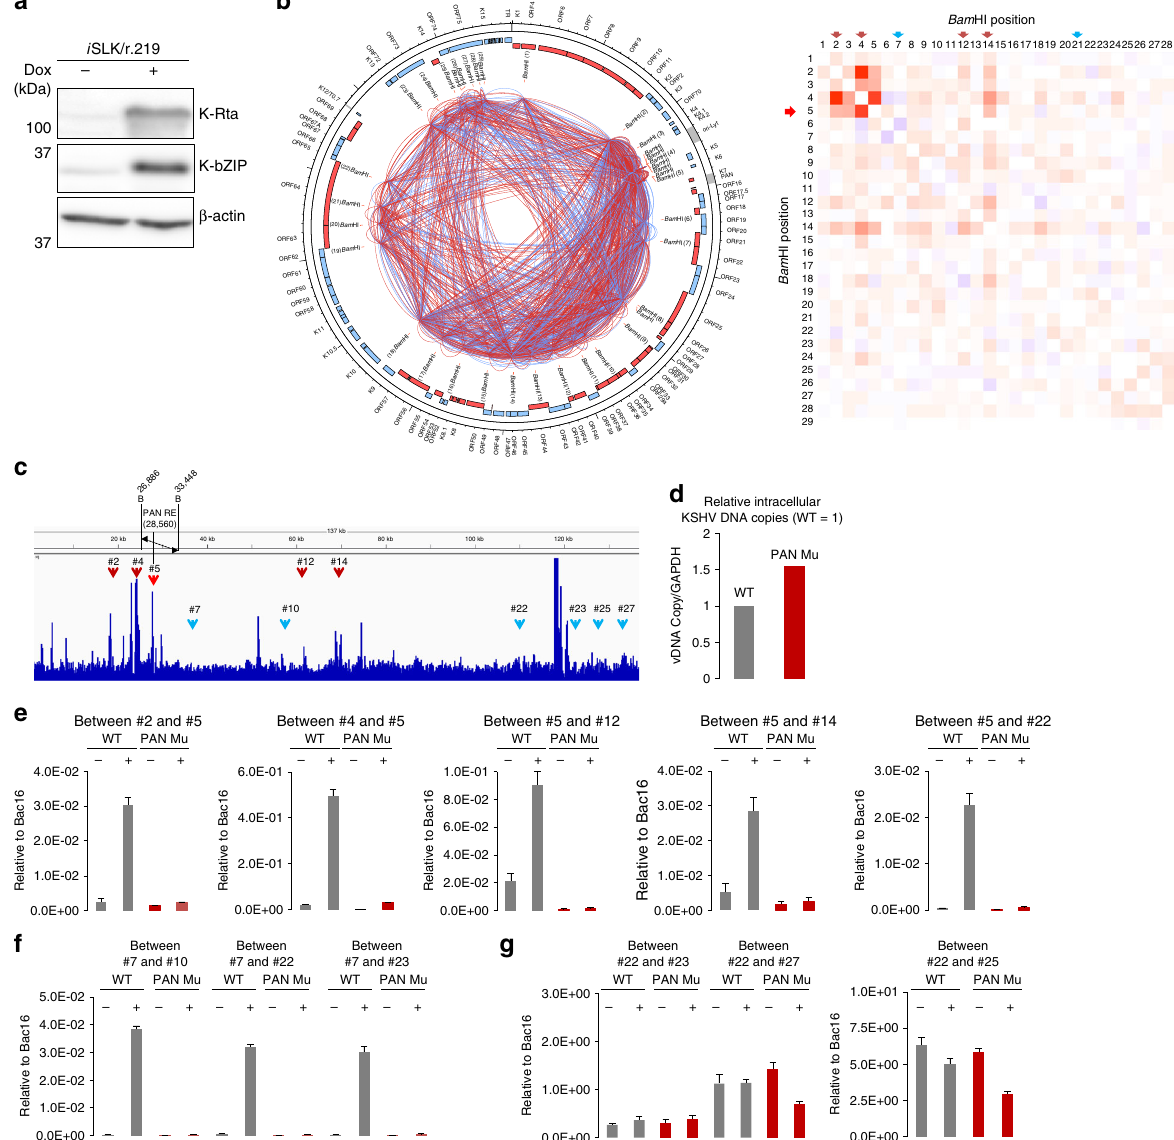
Fig. 6 KSHV genomic loop formation in KSHV infected i SLK cells. a KSHV lytic protein expression. Immunoblotting analysis of K-Rta or K-bZIP expression in i SLK/r.219 cells during latency ( − ) and at 24 h post-dox treatment (+). b (Left panel) Circos diagram depicting KSHV genomic links detected by Capture Hi – C. Arcs indicate genomic links before (blue) or after (red) K-Rta induction in i SLK/r.219 cells. Black outer hatches mark genomic positions and ORF names are indicated in the outer circle. Position of Bam HI sites are indicated and numbered. (Right panel) Movement of genomic links during KSHV reactivation in i SLK cells. Increase/decrease of KSHV genomic loops was calculated similarly to that described in Fig. 2, and visualized by heatmap by using R package ggplot2. c Effect of K-Rta binding to PAN RE on loop formation. K-Rta ChIP seq plot and interaction sites are shown. The Bam HI fragment encompassing PAN is shown with anchor primers depicted. Target sites are indicated with red (K-Rta enriched) or blue (K-Rta valley) arrowheads. Arrowhead numbers refer to the Bam HI sites listed in the Circos plot in Fig. 6b. d Relative intracellular KSHV copy number WT = 1. Values were determined by qPCR on isolated total DNA from each latent cell line. e Real-time PCR analysis of 3C ligation products using anchor primers located on the Bam HI fragment containing PAN K-Rta RE (#5) with Bam HI acceptor primers as listed. PCR products were quanti fi ed relative to products from a BAC16 control Bam HI re-ligation matrix. qPCR results using a forward anchor/acceptor primer pair 18 are shown. Non-K-Rta enriched regions. f Induced contacts. Real-time PCR analysis of 3C ligation products ( ± dox 24 h) using an anchor primer located on the Bam HI fragment (#7) with Bam HI acceptor primers listed (#10, nt 36,700; #22, nt 111,299; #23, nt 123,970) and PCR products were quanti fi ed relative to products from a BAC16 control Bam HI re-ligation matrix. g Constitutive contacts. Real-time PCR analysis of 3C ligation products using an anchor primer located on the Bam HI fragment (#22) with Bam HI acceptor primers listed (#23, nt 123,970; #27 nt 134,049, #25 nt 129,537). Values (mean ± SD, n = 3) represent signals obtained relative to a BAC16 Bam HI